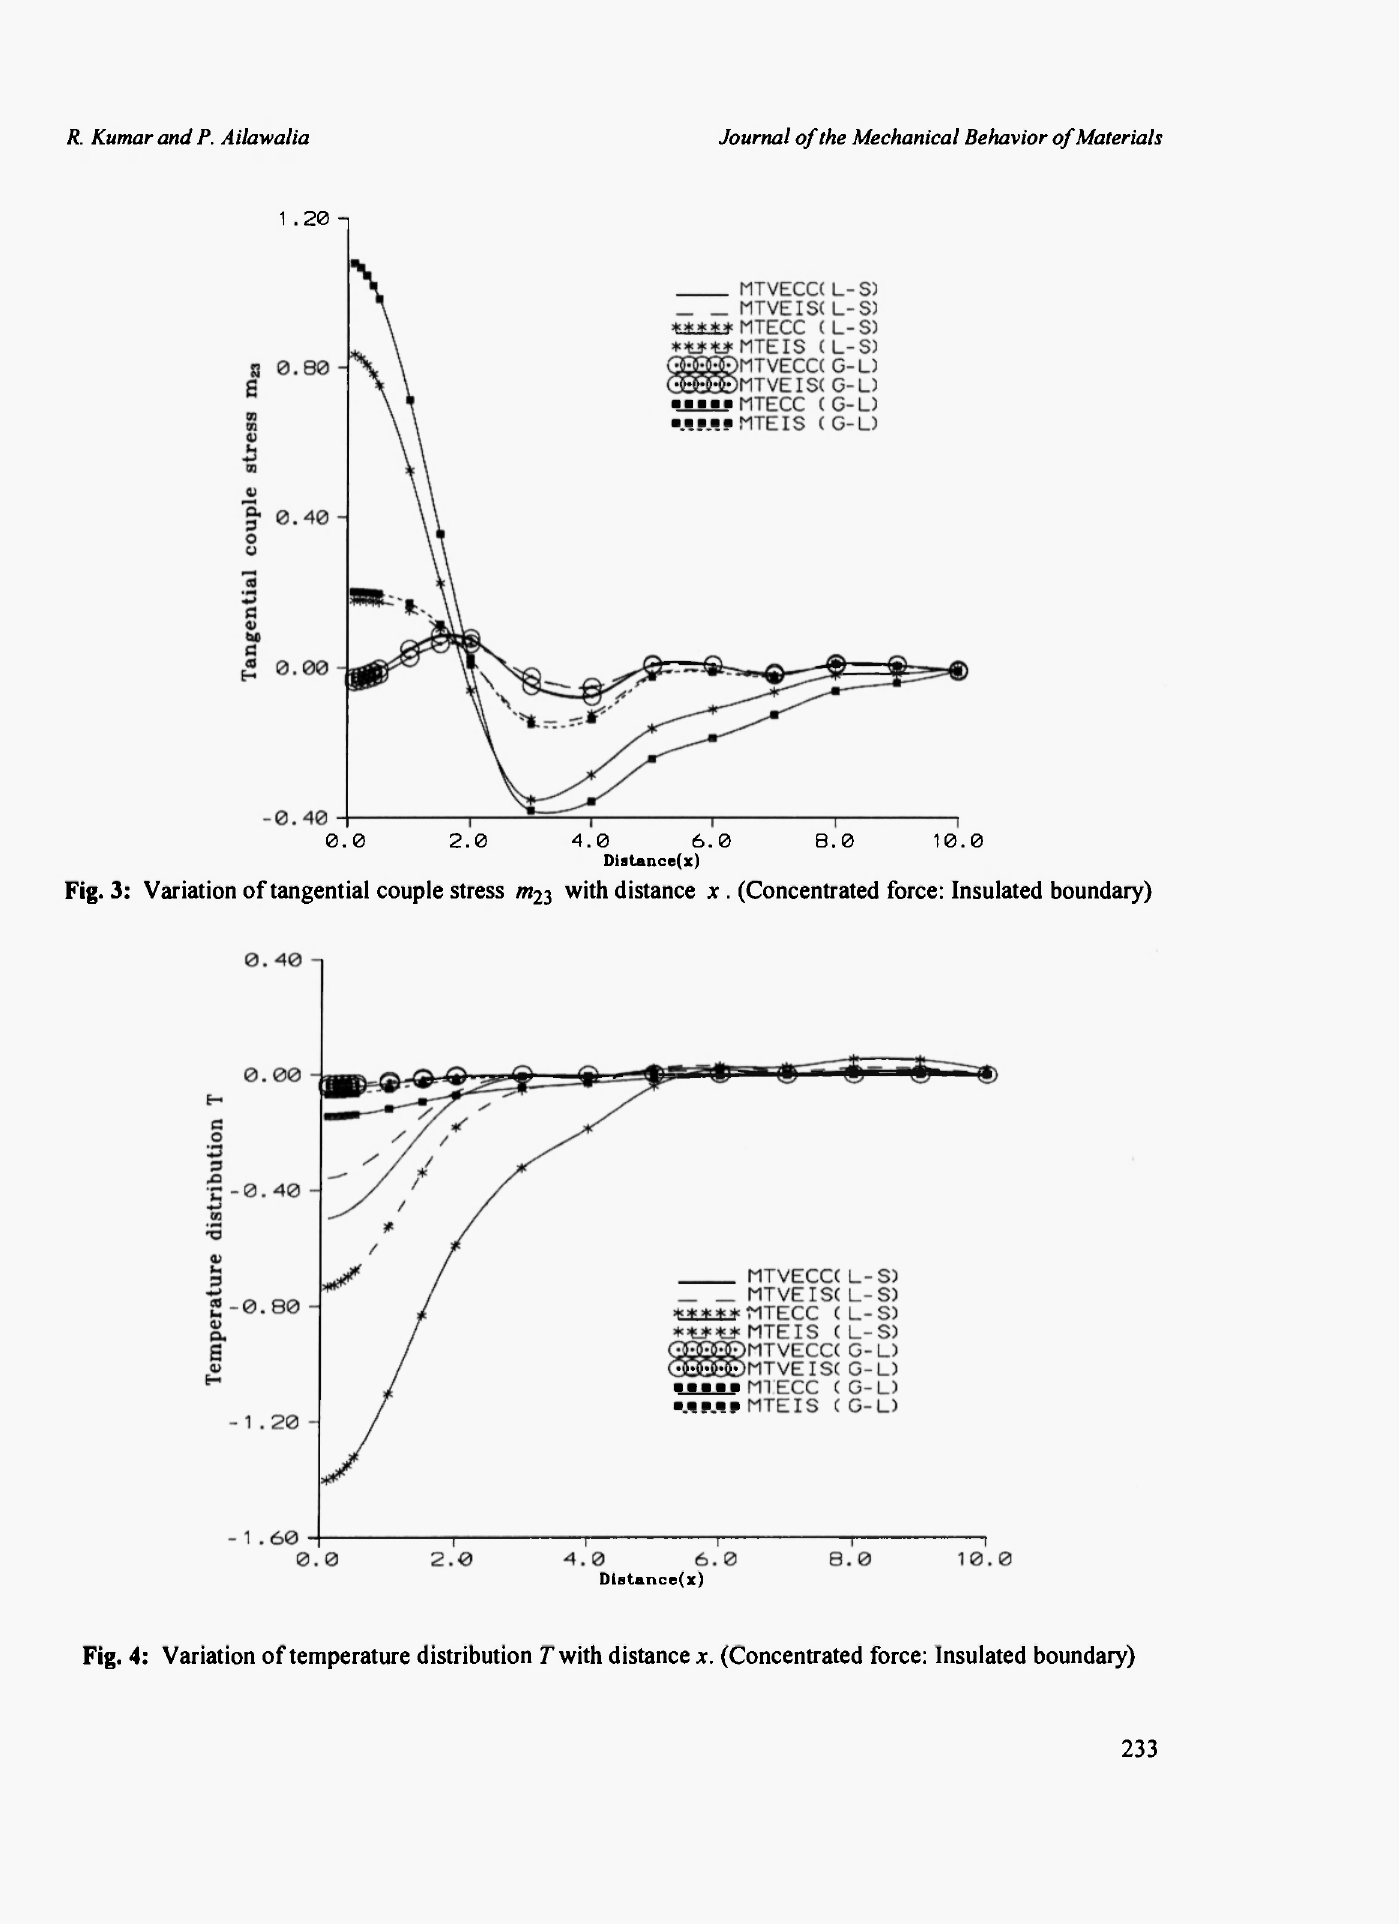
Fig. 4: Variation of temperature distribution Γ with distance x. (Concentrated force: Insulated